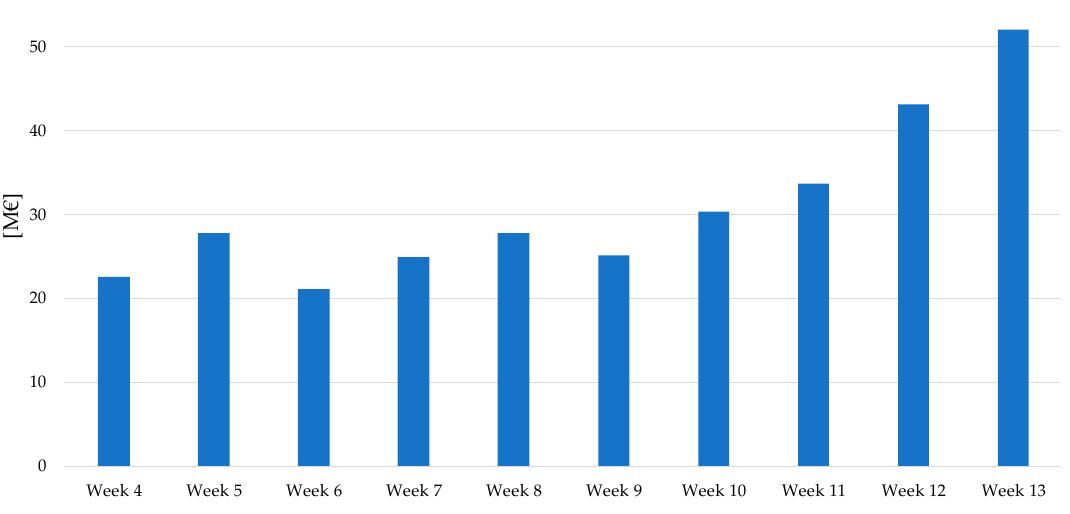
Figure 24. Weekly system costs for ancillary services, per each market zone.